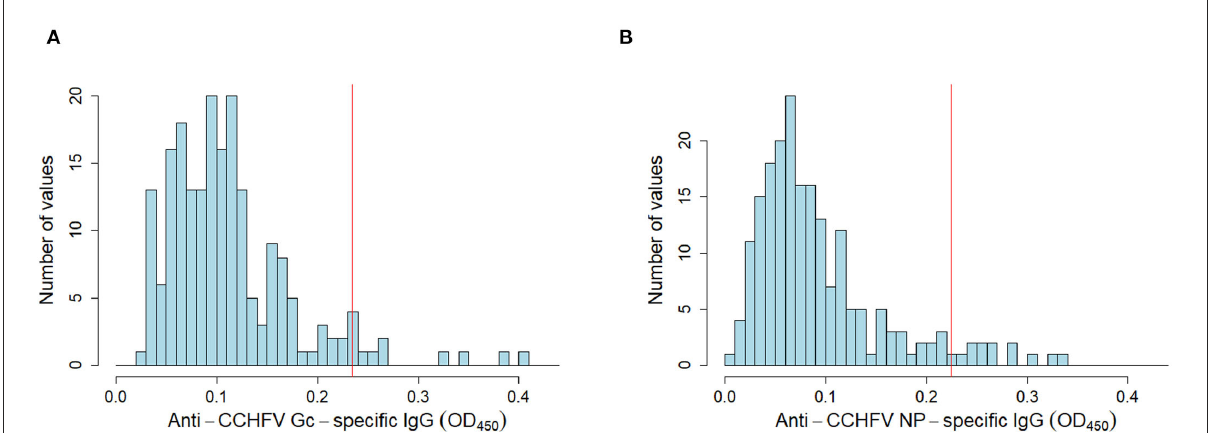
FIGURE2 Anti-CCHFV Gc-specific and NP-specific IgG in sheep sera from non-endemic CCHFV areas. Sheep sera were collected from a non-endemic CCHFV country ( n = 200) and tested for anti-CCHFV Gc-specific (A) NP-specific (B) IgG sero-reactivity by in-house assays. Data are represented as histograms of the distribution of the OD 450 values frequency (blue bars). Estimated cut-off from finite-mixture model in an endemic area (same as Figure 1) is presented as a red solid